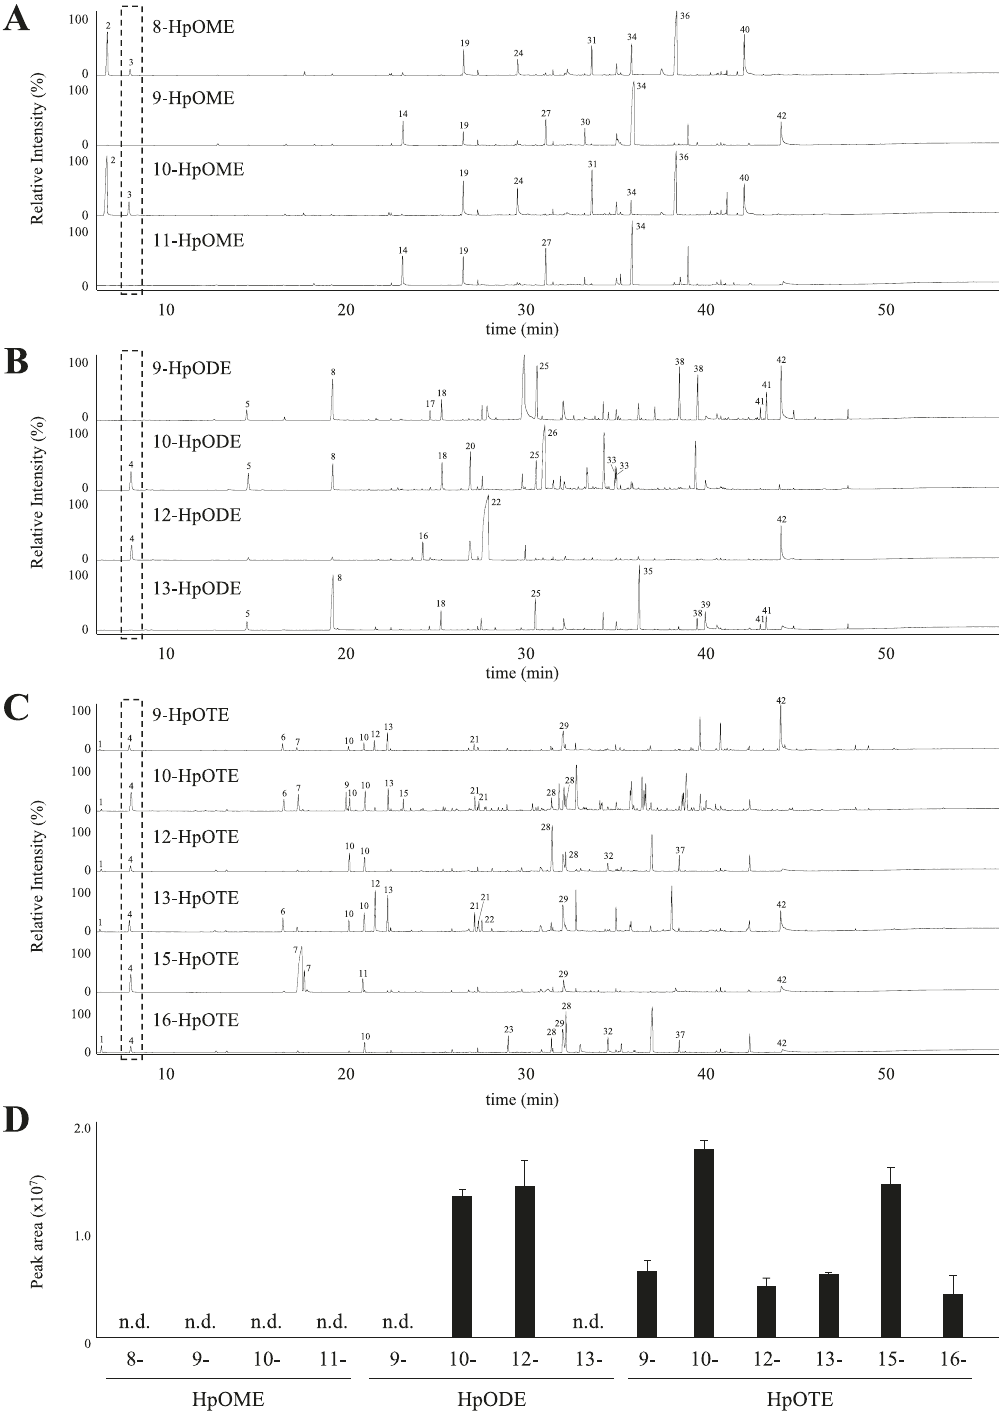
Fig. 3 Volatile compounds derived from each FAOOH isomer. GC-EI-MS chromatograms of volatile compounds ( A HpOME; B HpODE; and C HpOTE). Identi fi ed compounds (peak number 1 – 42) are summarized in Table 1. The amount of acrolein generated from each FAOOH isomer ( D ). Data are expressed as means ± SDs ( n =